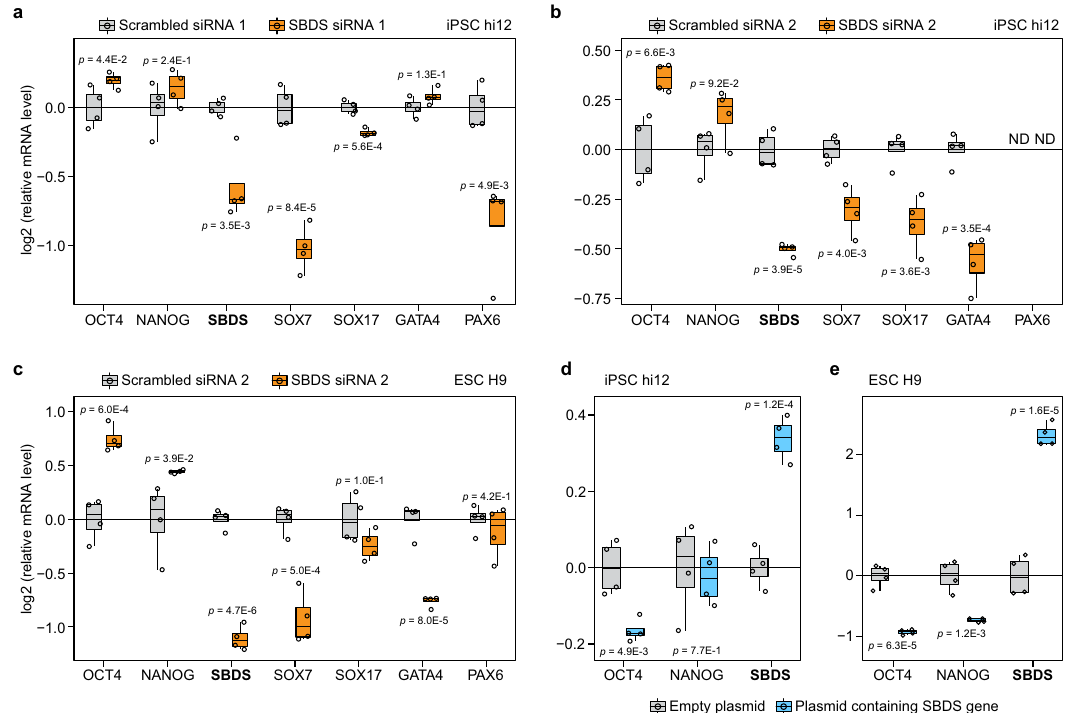
Fig. 7 SBDS knockdown promotes maintenance of pluripotency and knockin decreases expression of pluripotency markers in PSCs. Relative mRNAs abundance of pluripotency (OCT4 and NANOG) and lineage speci fi c markers (SOX7, SOX17, GATA4, and PAX6) after 3 days of scrambled siRNA 1 and SBDS siRNA 1 treatments ( a ) or scrambled siRNA and SBDS siRNA 2 treatments ( b ) in iPSCs hi12 and scrambled siRNA 2 and SBDS siRNA 2 treatments in ESCs H9 ( c ) grown on Geltrex ™ . Relative mRNAs abundance of pluripotency markers (OCT4 and NANOG) after knockin of SBDS protein in hi12 ( d ) and H9 ( e ). Horizonal line in the boxplots represent the median, 25th and 75th percentiles and whiskers represent measurements to the 5th and 95th percentiles. ND nondetected. P -values were calculated using a two-sided Student t -test. p < 0.05 were considered as signi fi cant. n = 4 biologically independent samples for all experiments. Source data are provided as a Source Data fi